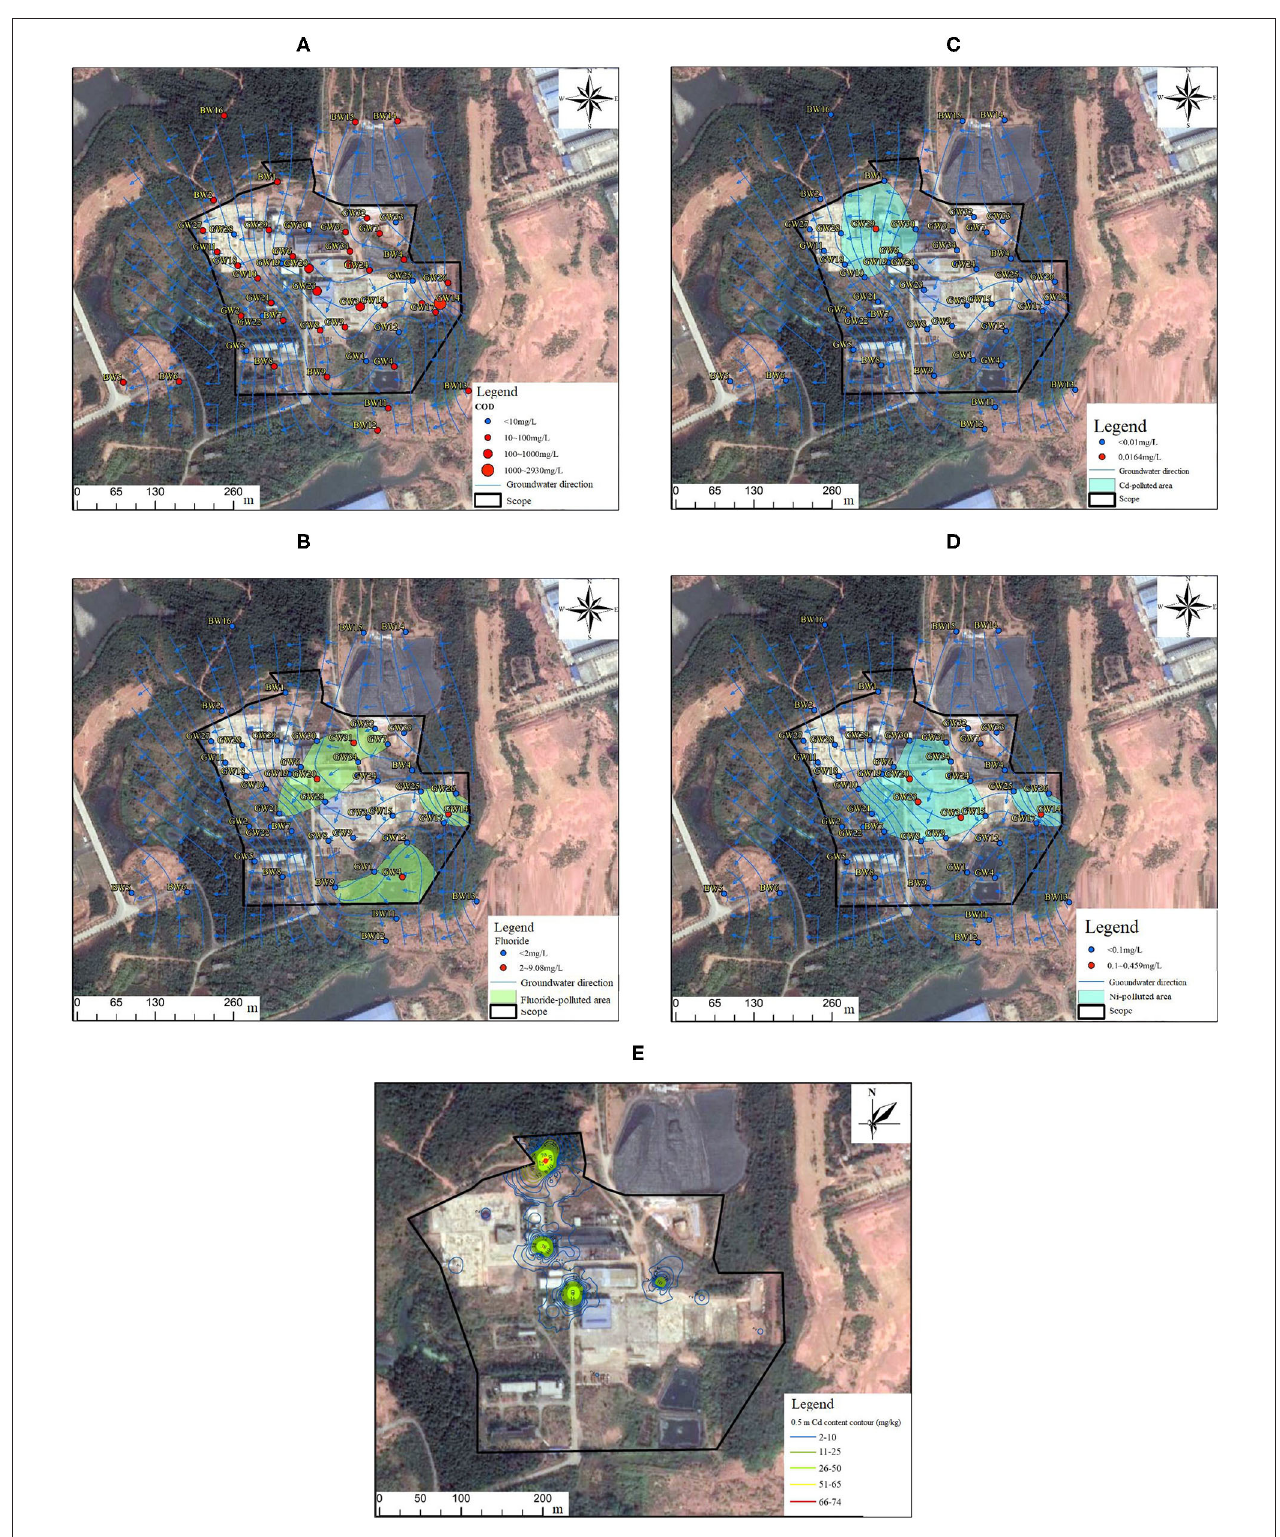
FIGURE 3 | Spatial characterization of the sampling points exceeding COD (A) , fluoride (B) , Cd (C) , and nickel (D) standard in groundwater (GB/T 14848-2017) and spatial distribution of Cd pollution in 0.5m soil (GB36600-2018) (E) .